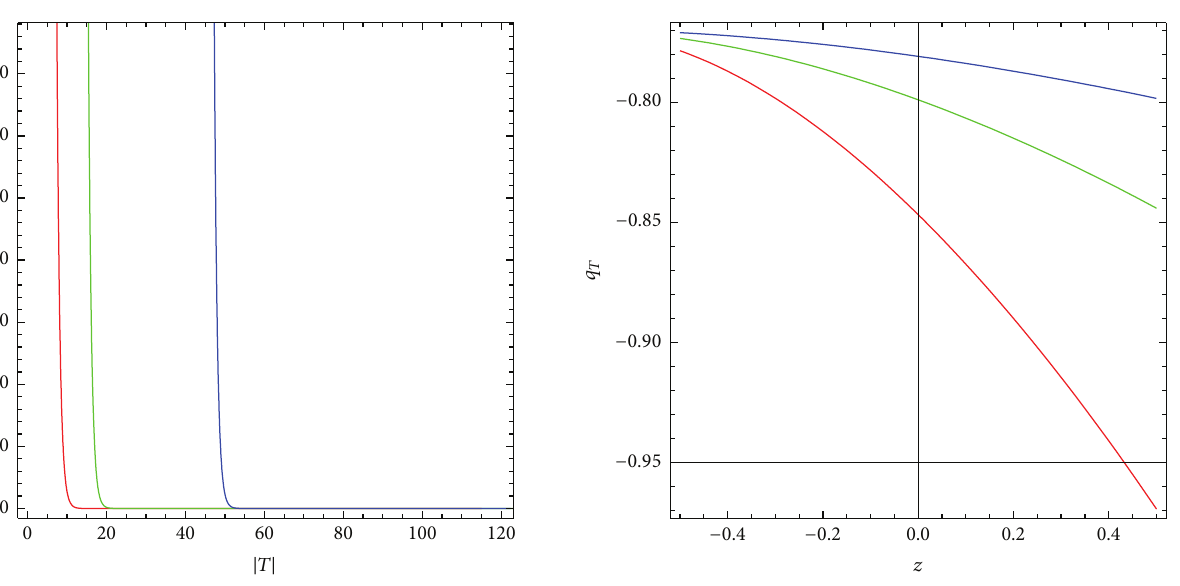
Figure11:Reconstructed 𝑓(𝑇) fortheexponentialmodelandwesee that 𝑓(𝑇) becomes a decreasing function of 𝑇 .